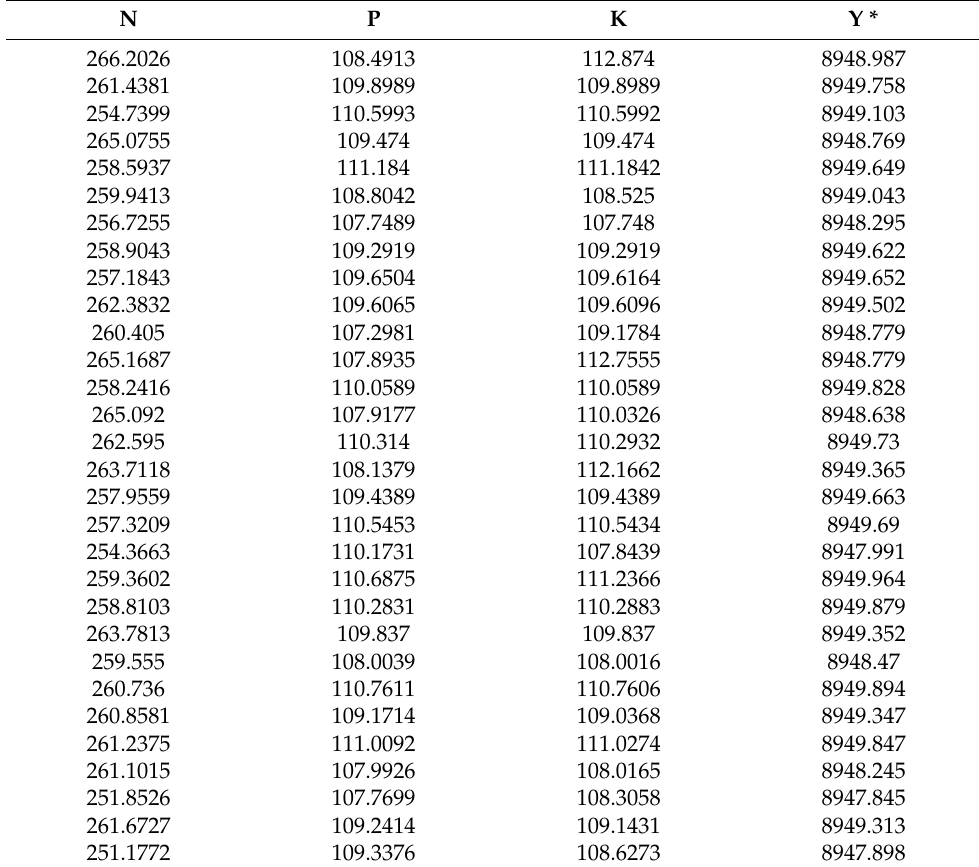
Table A2. Nitrogen, phosphorus, potassium, and yield prediction by SLEGWO.